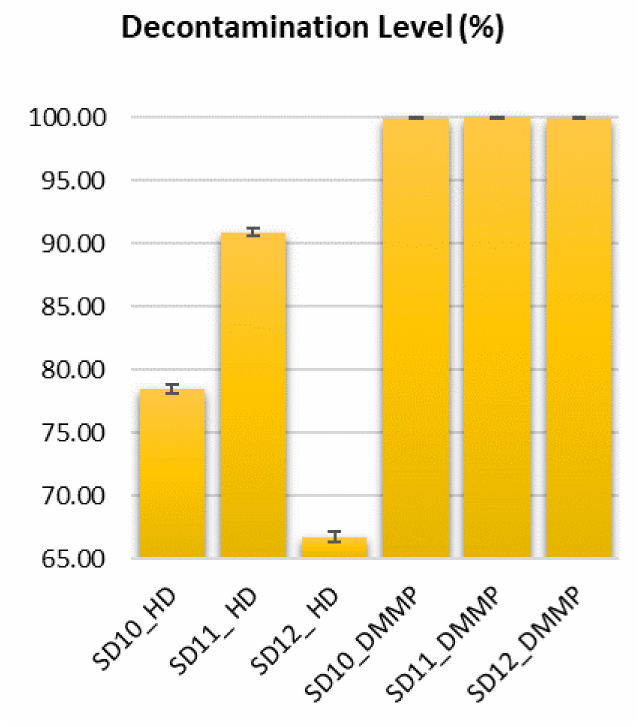
Figure 10. Chemical decontamination efficacy: decontamination